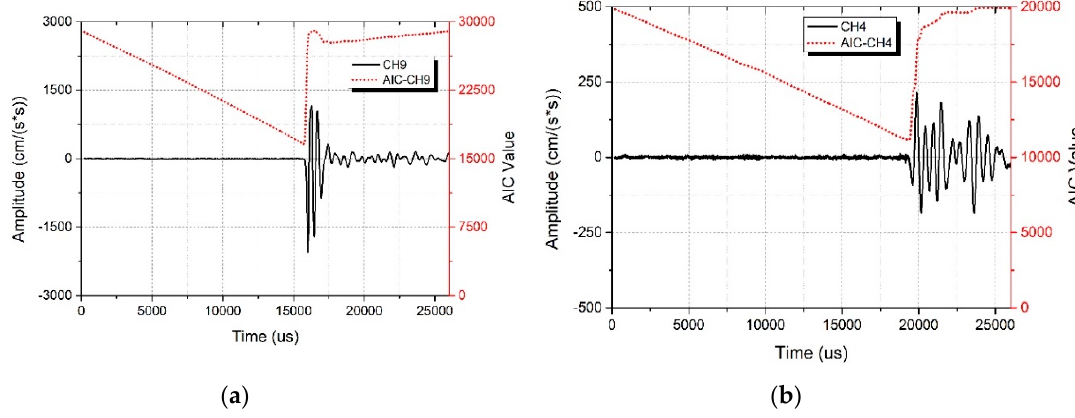
Figure 7. The waveform and AIC value. The AIC value is represented by the dashed line, the minimum AIC value denotes the first travel time. ( a ) Strong signal near the exciter, ( b ) weak signal far away from the exciter. Note the different scale on the y-axes in (a) and (b).